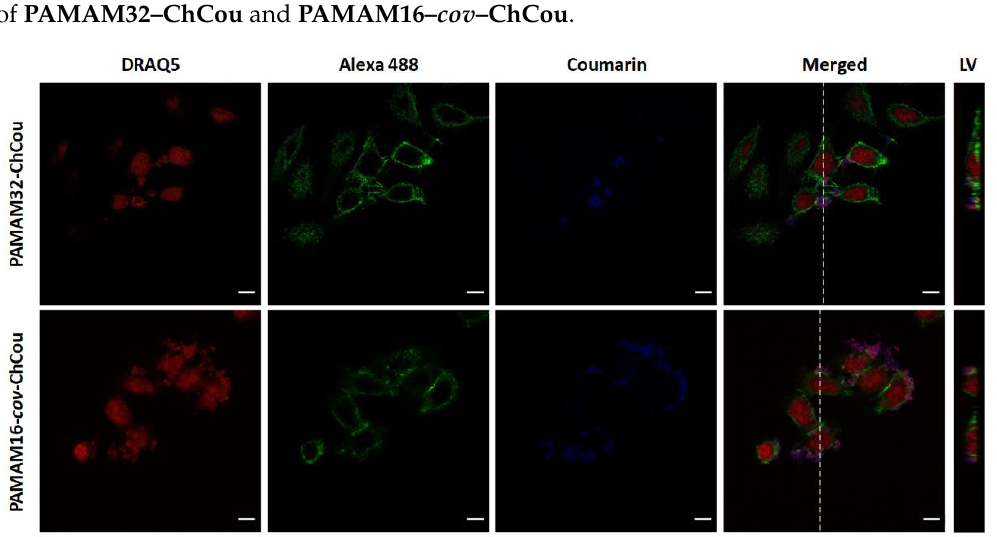
Figure 7. Confocal images of dendrimers PAMAM32–ChCou and PAMAM16– cov –ChCou in HeLa cells after 4 h of incubation at 0.50 mg/mL. Images were acquired at different channels: DRAQ5 ( red ), Alexa 488 ( green ) and coumarin ( blue ). Merged images of these three channels are also shown. LV: Lateral view of the merged images obtained by arranging several confocal Z-stack projections obtained from the points indicated by the white dashed lines. Scale bars: 10 μm.